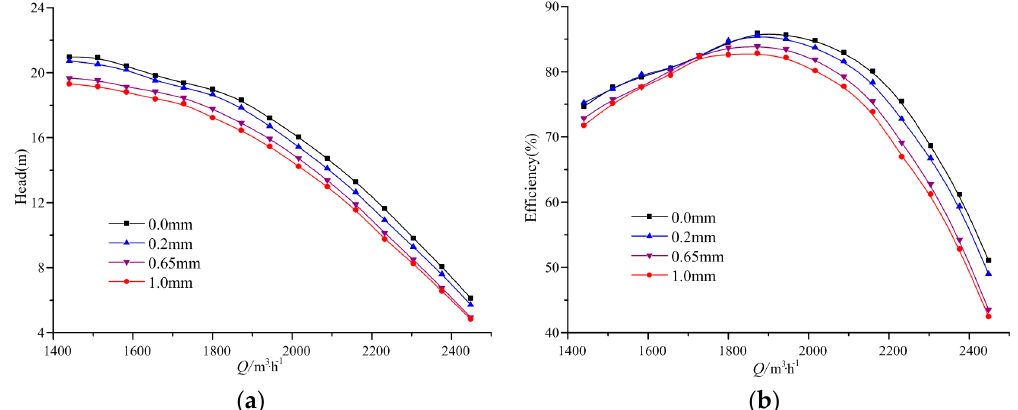
Figure 6. Variation of pump head and efficiency for different tip clearance sizes. ( a ) Variation of head; ( b ) variation of